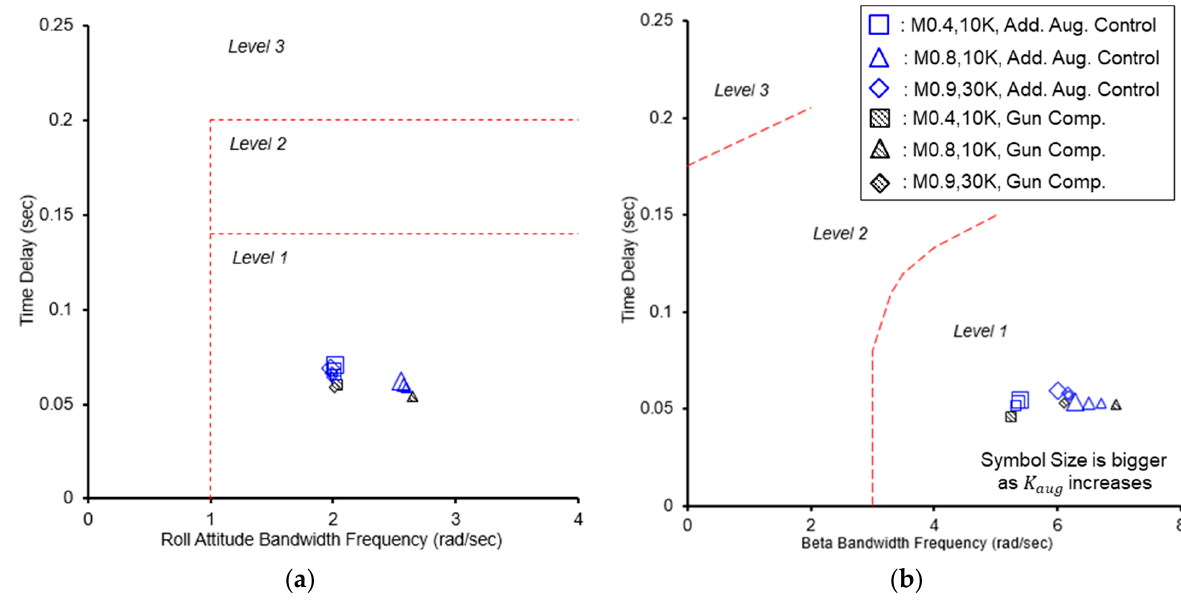
Figure 7. Result of bandwidth analysis: ( a ) roll a tt itude bandwidth; ( b ) sideslip bandwidth. The Gibson phase rate criterion [41] concerns the open-loop a tt itude frequency re- sponse in the region around the –180° a tt itude phase. The average phase rate is derived from the excess phase lag between the pilot-induced oscillation (PIO) frequency and twice that frequency. Figure 8 shows the result of the Gibson phase rate in fl ight conditions for each control method. The Gibson phase rate increases at − 180° phase delay frequency as 𝑲 (cid:3028)(cid:3048)(cid:3034) increases, satisfying fl ying quality level 1 below 50 °/Hz.